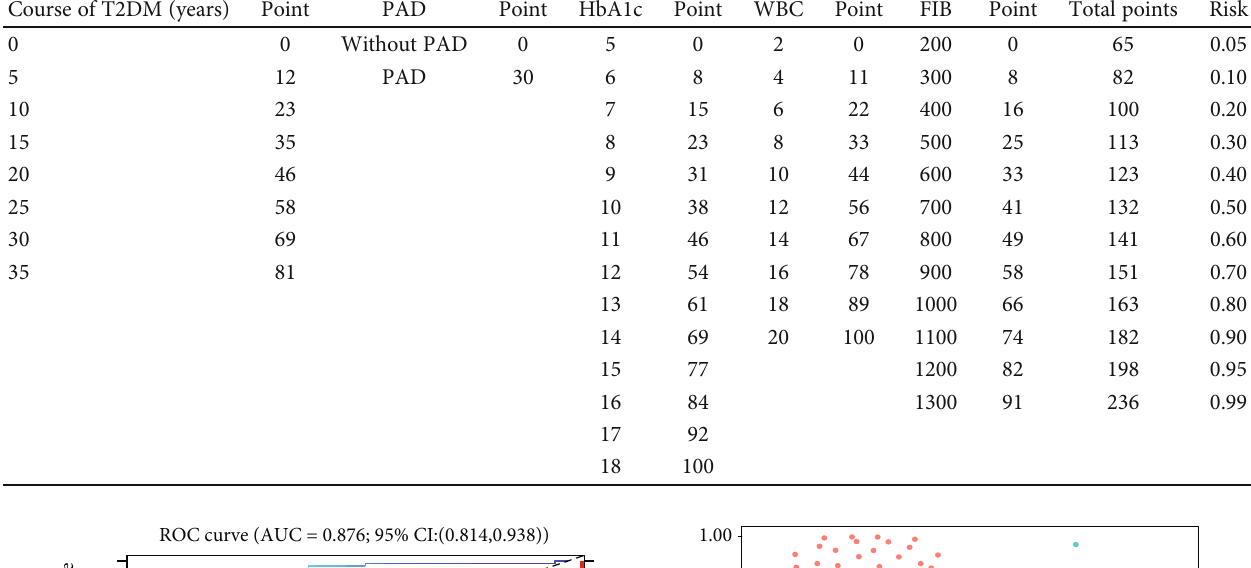
Table 3: Di ff erent index score, total score, and risk rate of nomogram.